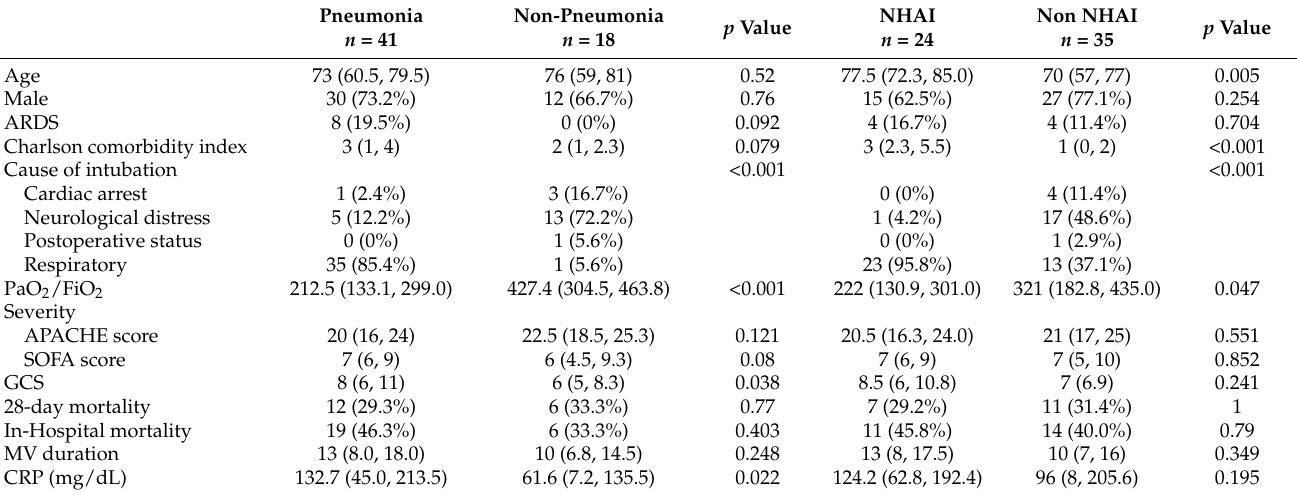
Table 1. Baseline characteristics of the study